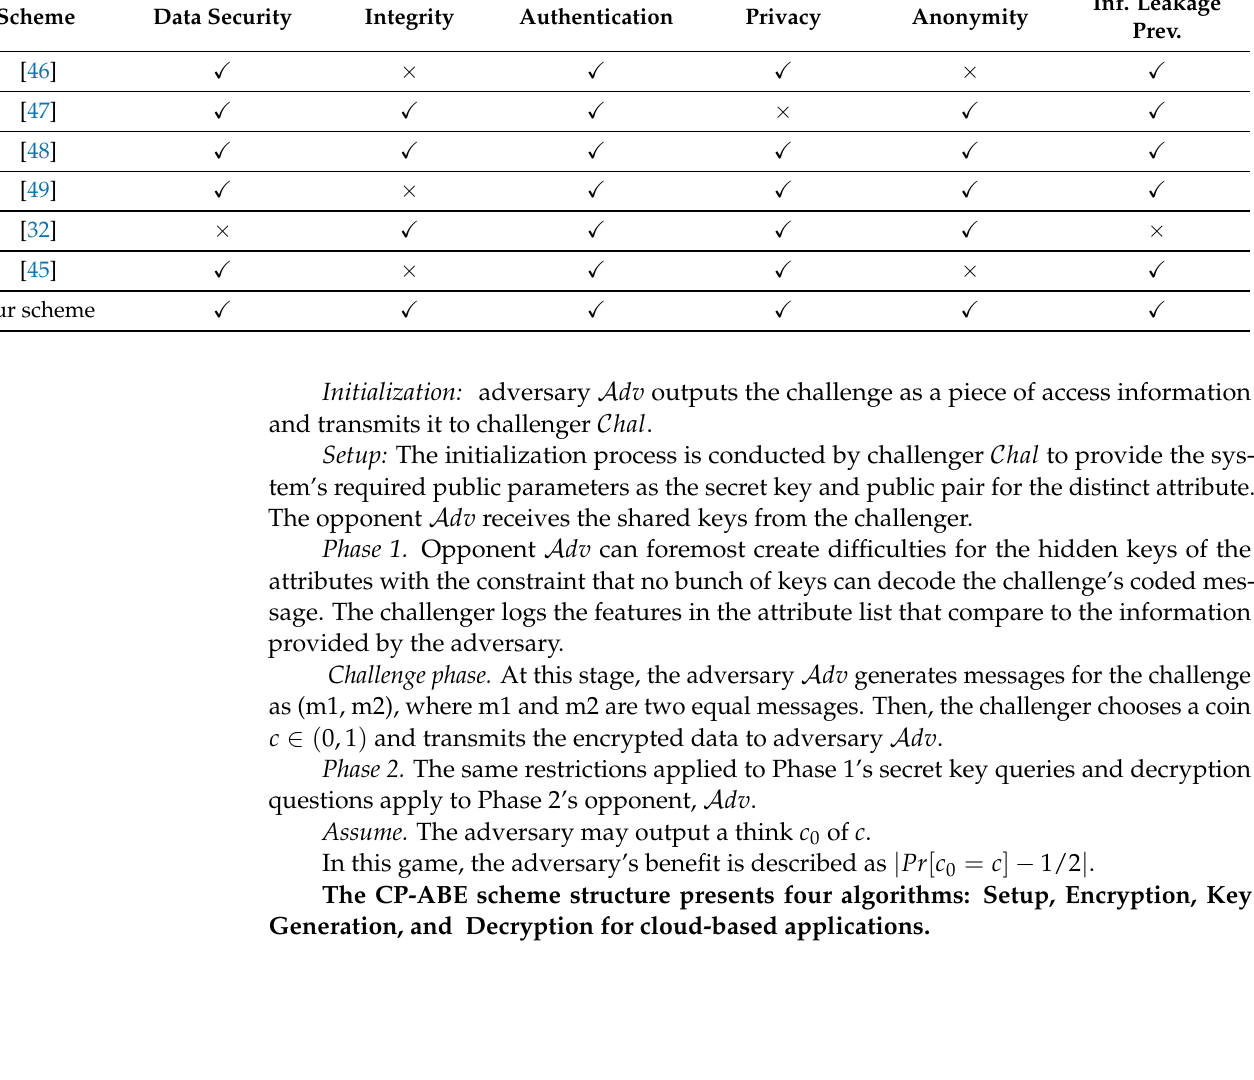
Table 3. Comparison of various security schemes and proposed scheme with different security services. Scheme Data